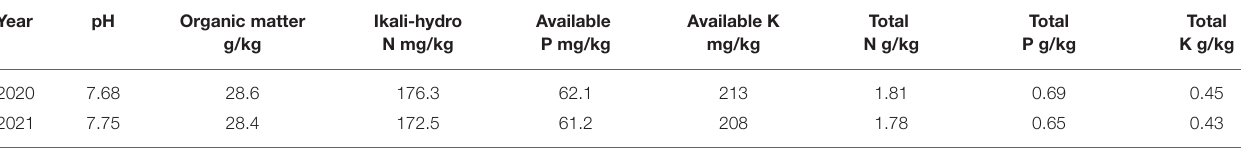
TABLE 1 | Background data of productivity and soil fertility of the experimental fields studied from 2020 to